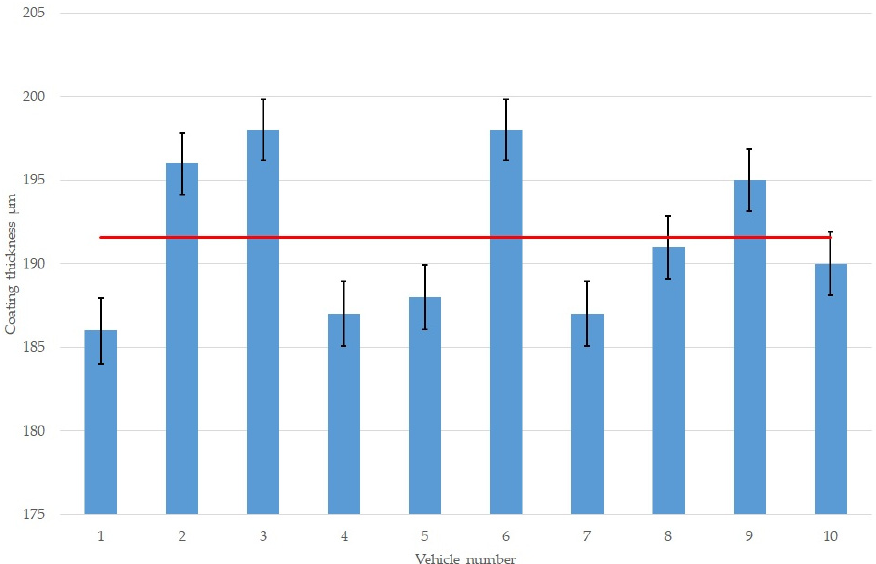
Figure 7. Average coating thickness on the vehicle roof for segment B vehicle (for all 10 vehicles), by the red line, the mean value from 10 vehicles is added.